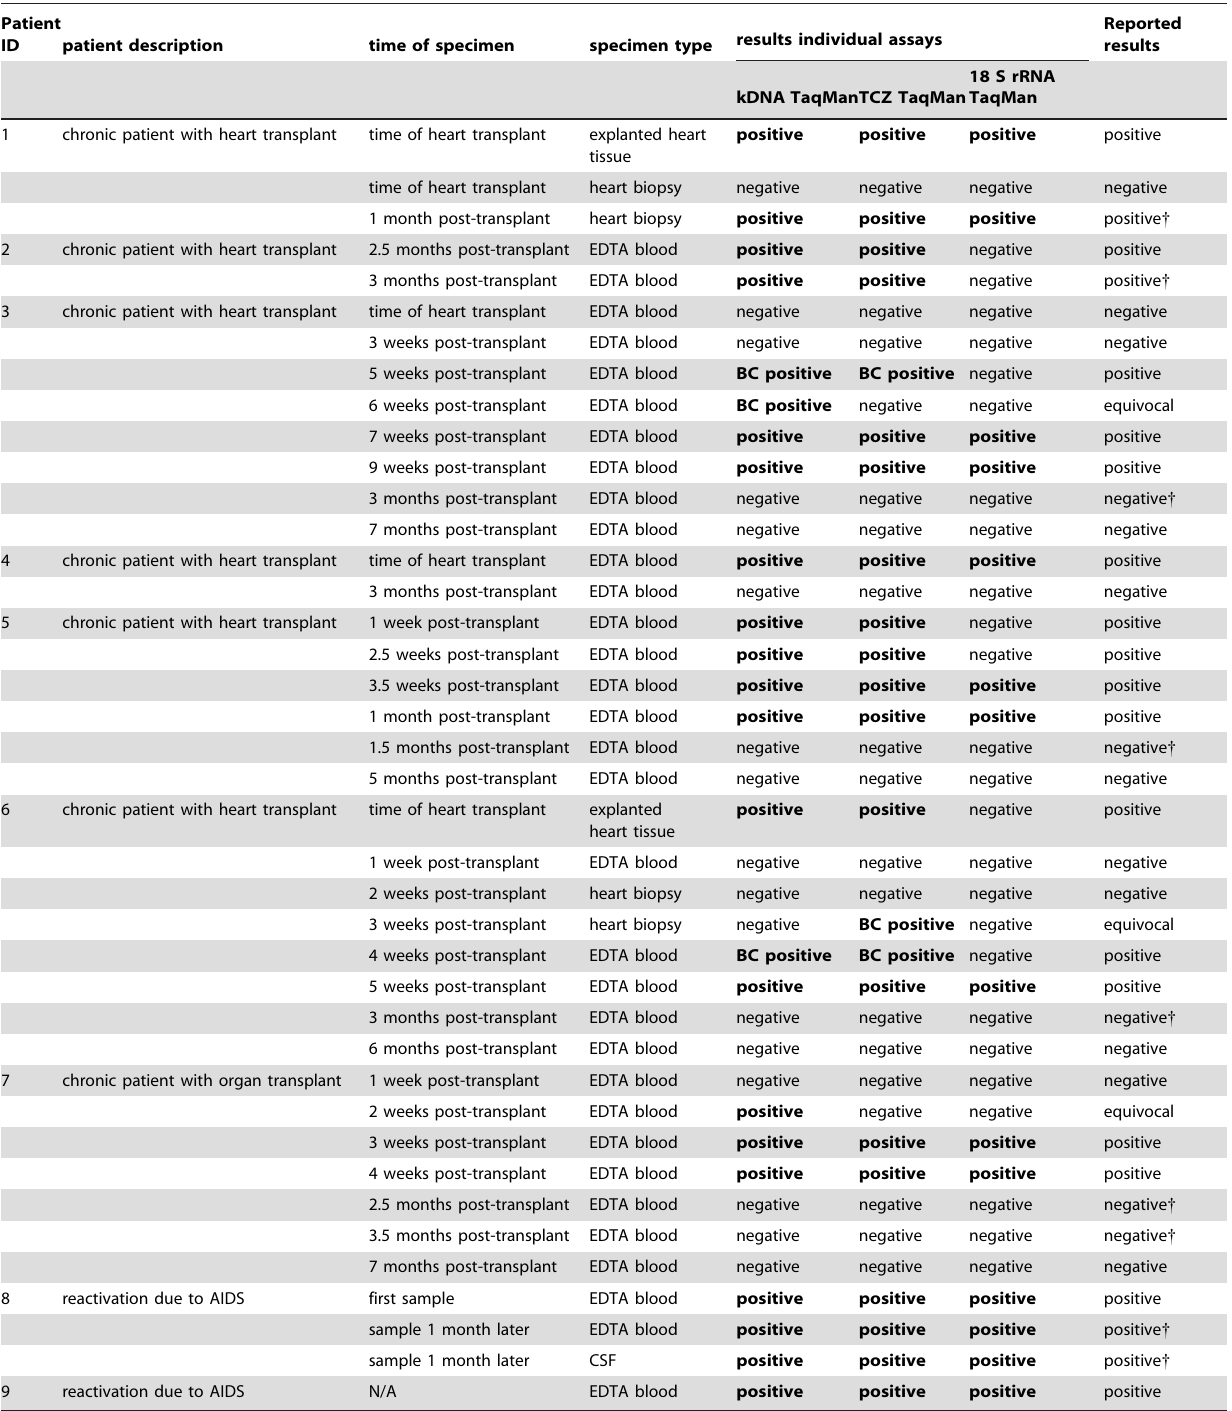
Table 3. Detailed PCR findings from patients with reactivation